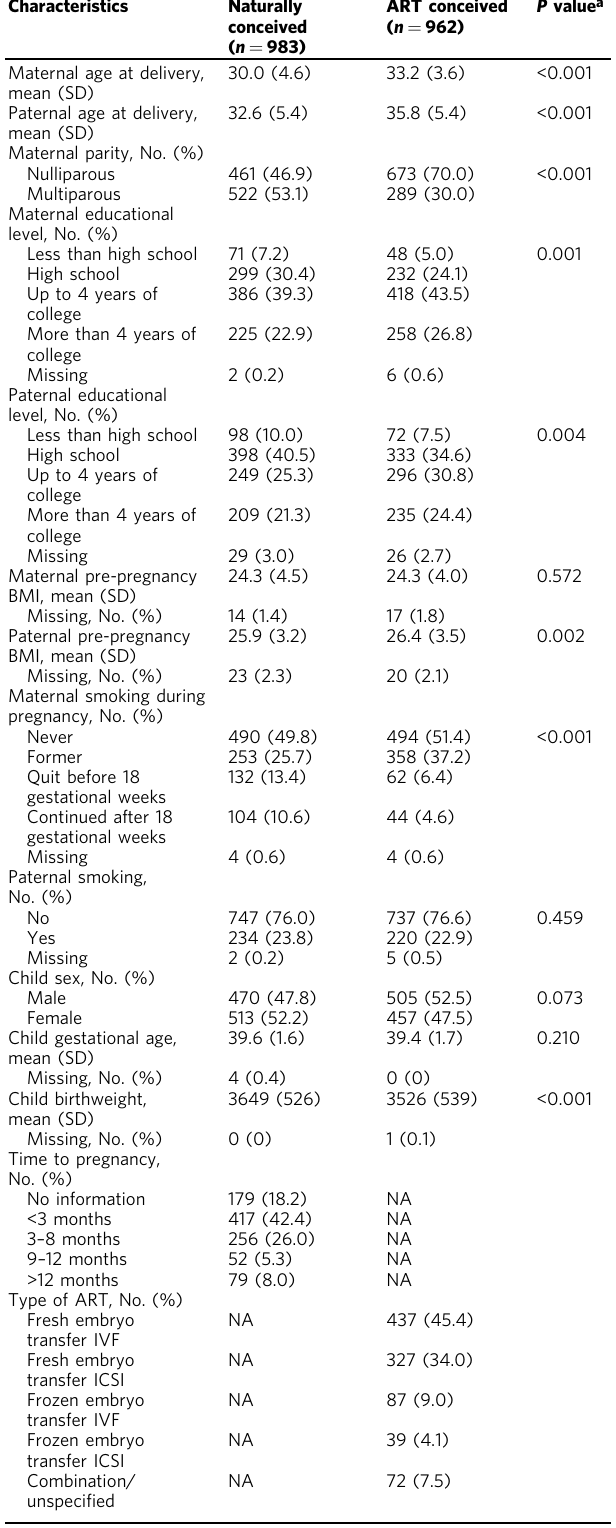
Table 1 Characteristics of the study